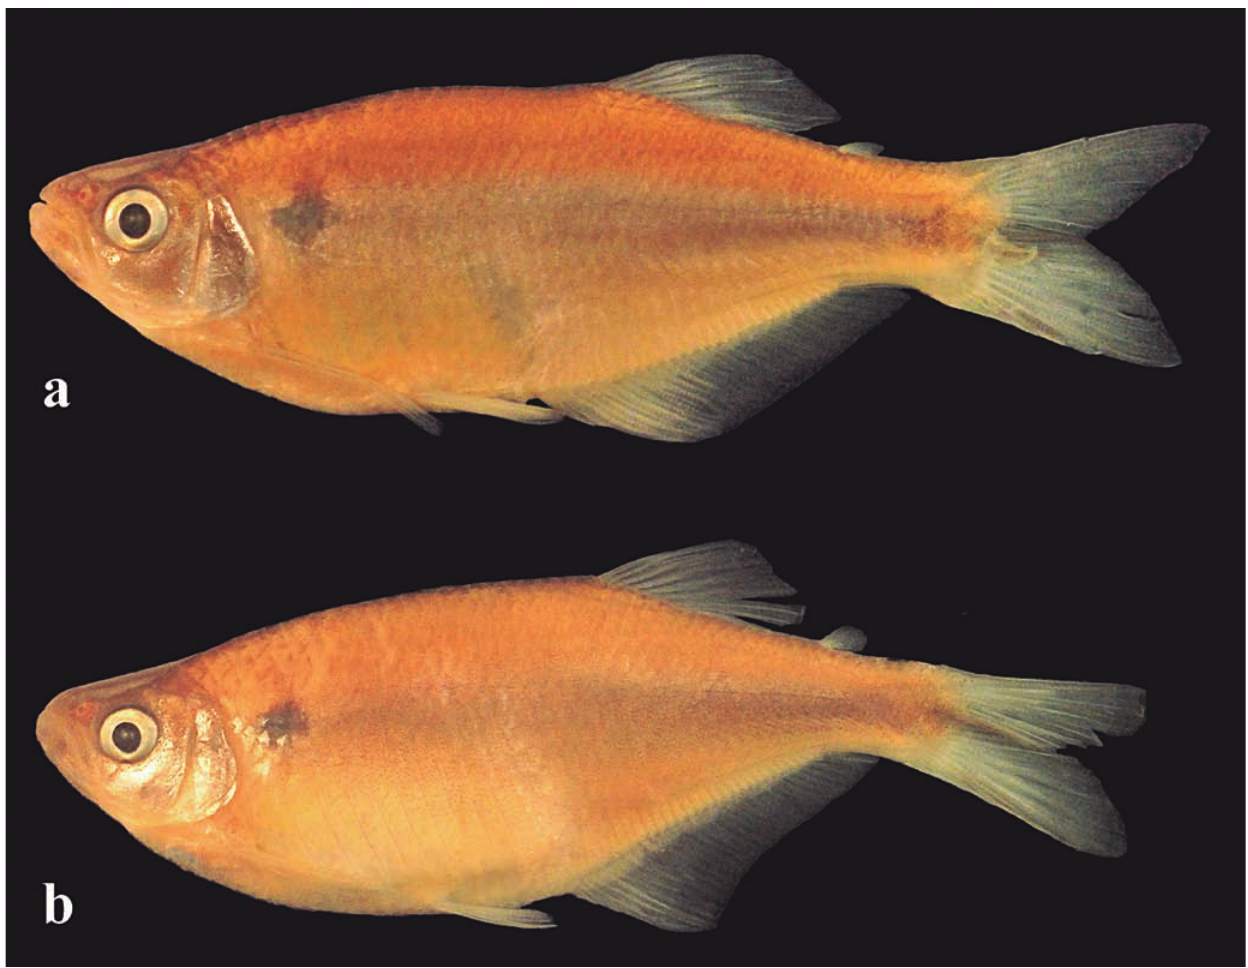
Fig. 1. Chrysobrycon yoliae , ( a ) MUSM 46140, holotype male, 51.6 mm SL, Peru, Ucayali, Coronel Portillo, Abujao, río Ucayali basin, río Yucamia system, unnamed Quebrada; ( b ) MUSM 46141, paratype female, 51.5 mm SL, collected with